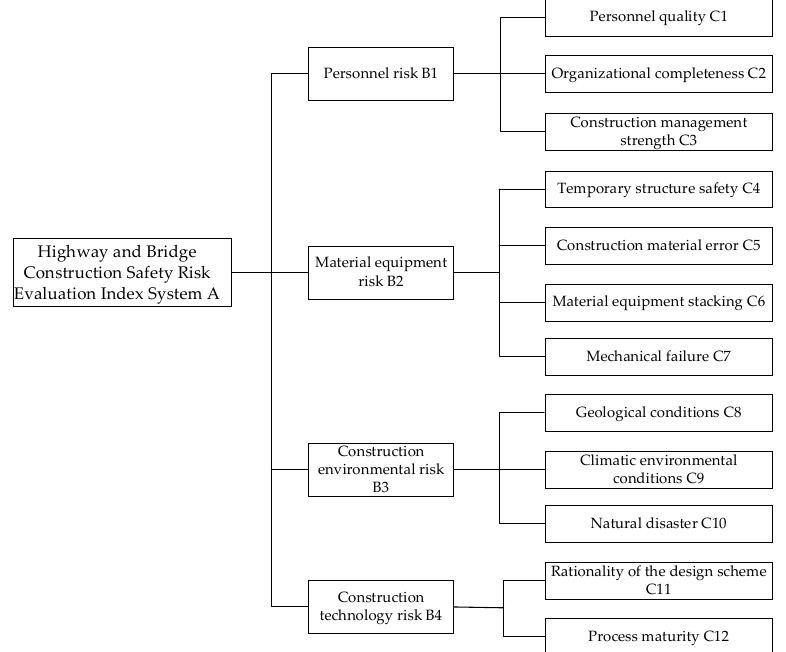
Figure 2. Highway bridge construction safety risk evaluation index system.